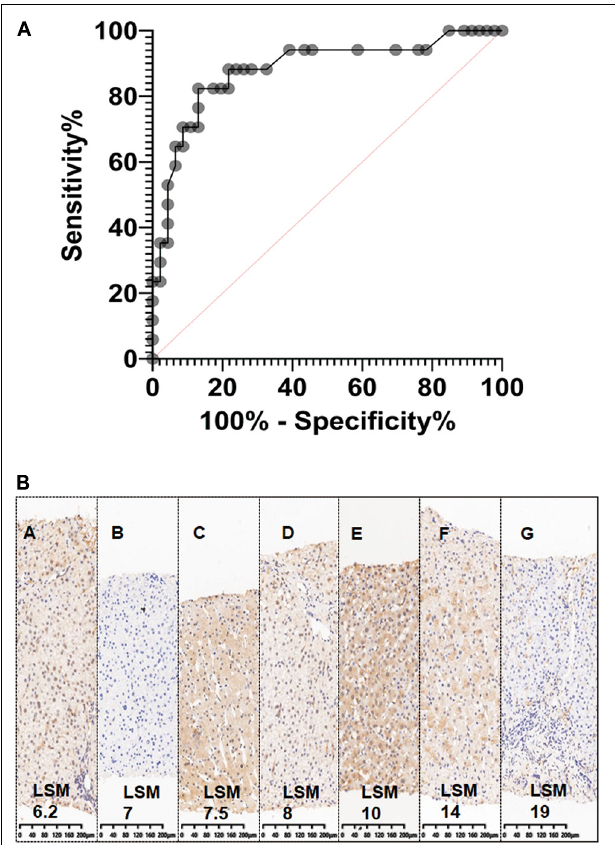
FIGURE 3 | The sensitivity and specificity of two-dimensional shear wave elastography (2D-SWE). (A) . Graph shows receiver operating characteristic (ROC) for 2D SWE values in the liver graft to differentiate fibrosis and non-fibrosis. It also shows sensitivity and specificity of 2D-SWE in diagnosing liver graft fibrosis, the AUC was 88% (95% CI 0.78–0.99%); (B) . No correlation was detected between Liver Stiffness Measurements (LSM) and C4D staining (immunohistochemistry staining), a biomarker for antibody-mediated rejection (ABMR) induced tissue